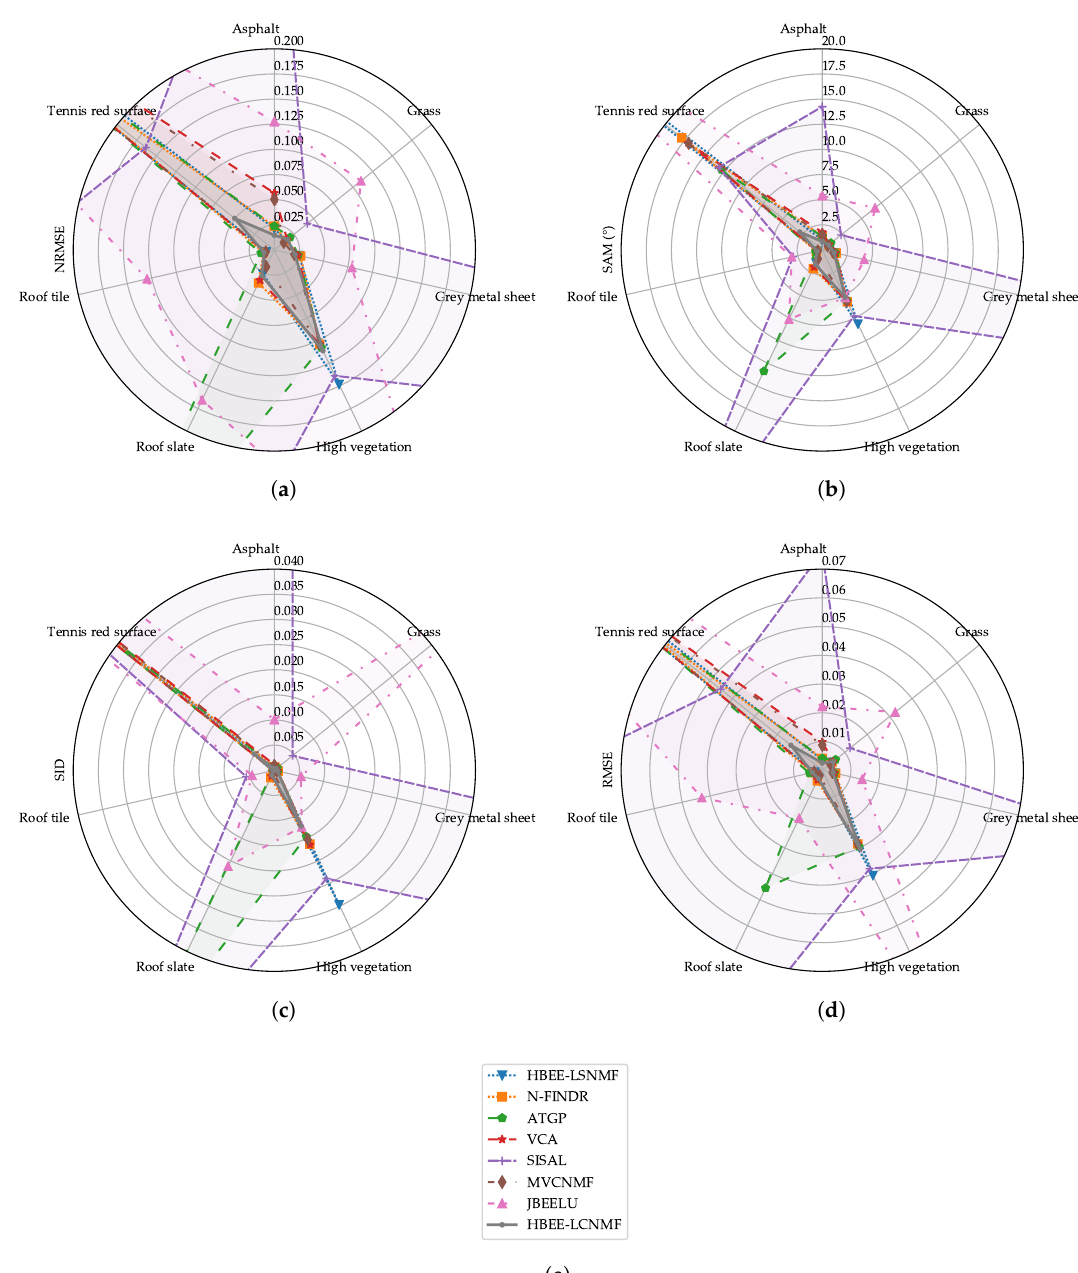
Figure 11. Normalized Root Mean Square Error (NRMSE) ( a ), spectral angle measure (SAM) ( b ), Spectral Information Divergence (SID) ( c ), and Root Mean Square Error (RMSE) ( d ) performances for each estimated endmember for the synthetic data set. The legend is given in ( e